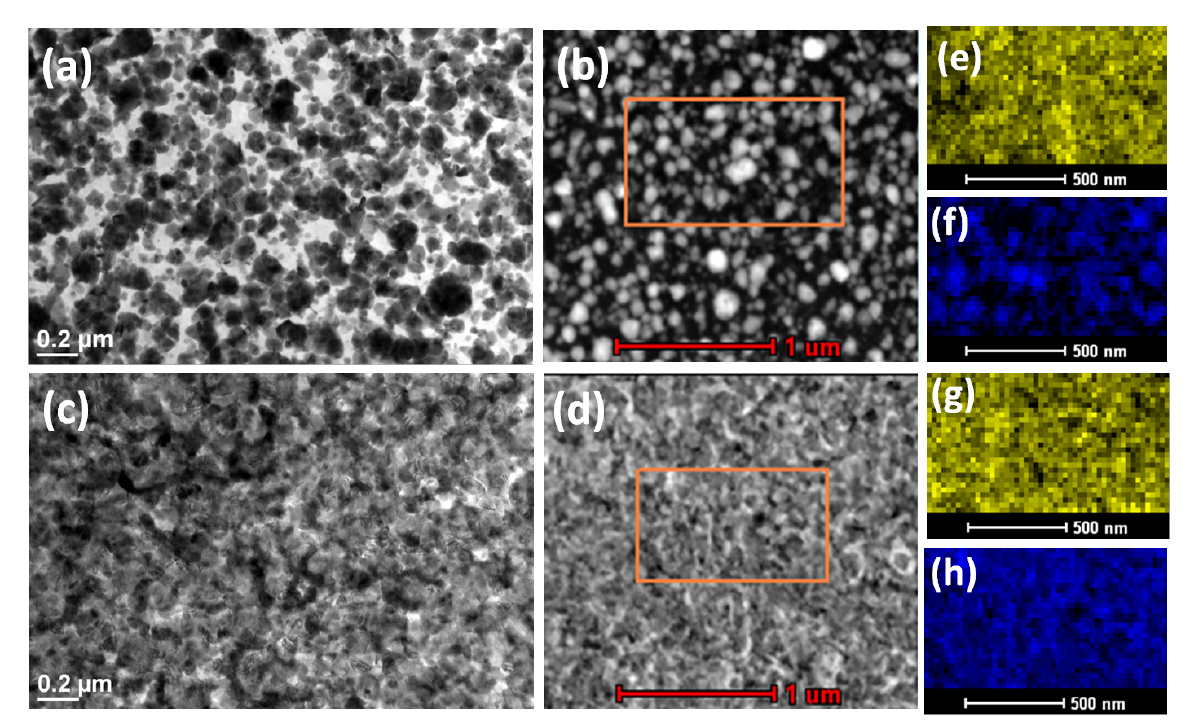
Figure 1: Plan view (a) TEM image (b) STEM-HAADF image of as-deposited copper nanoparticles on Si. Plan view (c) TEM image (d) STEM-HAADF image after the same nanoparticle substrate was annealed at 500 °C for 1 min under oxygen atmosphere. EDX elemental image (silicon (yellow) and copper (blue)): (e) and (f) collected from the orange rectangular area in figure (b); (g) and (h) collected from the orange rectangular area in figure